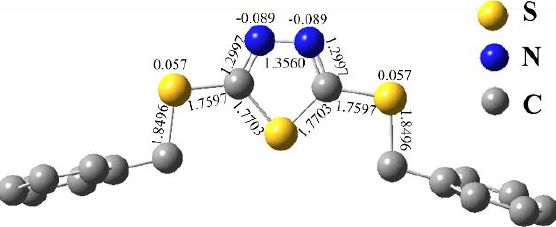
Figure 7. Adsorption of Pd (II) by PS-DMTD in the adsorption – desorption cycle. m PS-DMTD = 0.040 g, C Pd (II) = 100 mg/L, pH = 1.0, T = 298.15 K, t = 240 min, and V = 0.02 L.